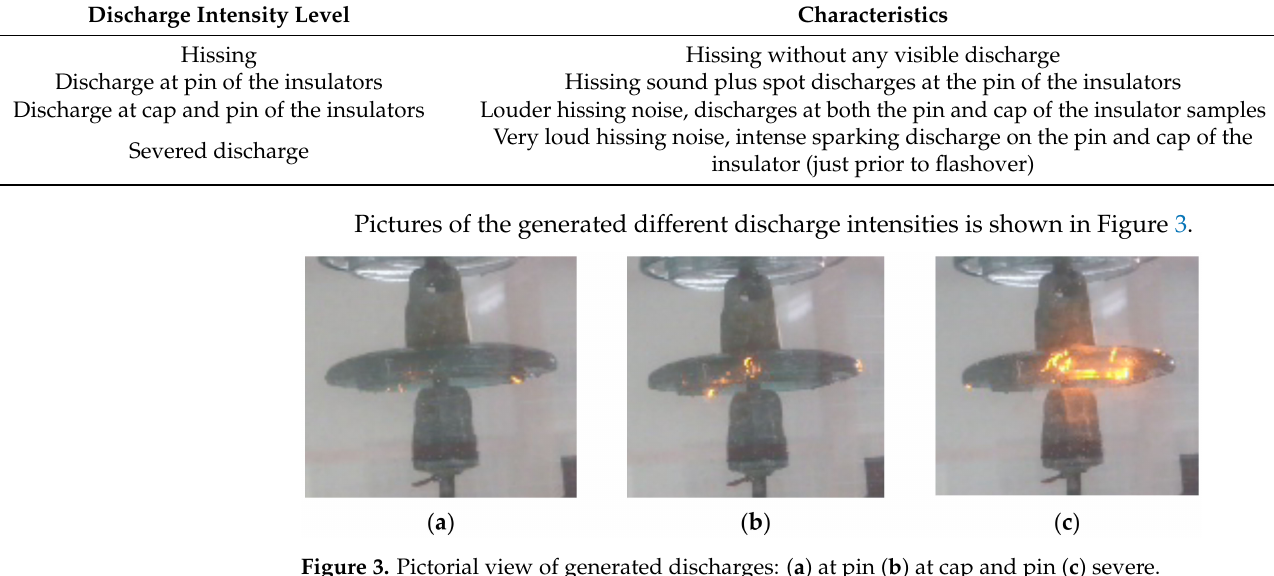
Figure 3. Pictorial view of generated discharges: ( a ) at pin ( b ) at cap and pin ( c )